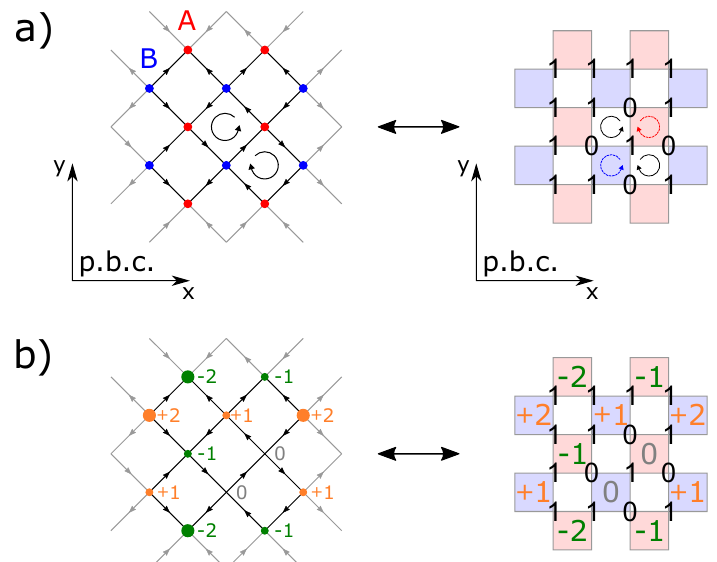
Figure 23: To see the connection between the QLM and the XY-plaquette model, it is convenient to represent QLM, that is formulated in terms of arrow d.o.f. on the links (left column), as a plaquette model with 0 / 1 d.o.f. on the sites of a square lattice rotated by 45° with respect to the original lattice, which is a natural framework for the XY-plaquette model (right column). (a) The vertices of the QLM are bipartitioned into A (red) and B (blue) sublattices. In the language of the XY-plaquette model, the number of plaquettes is doubled, with white plaquettes corresponding to the original plaquettes of the QLM, and blue / red plaquettes corresponding to the vertices of the QLM. Unlike in the QLM, in the XY-plaquette model we can additionally flip blue and red plaquettes. (b) Charges are defined on the vertices of the QLM in (21), i.e., on blue / red plaquettes in the XY-plaquette model language. They are conserved in the QLM, while this conservation is lifted when we allow blue / red plaquettes to